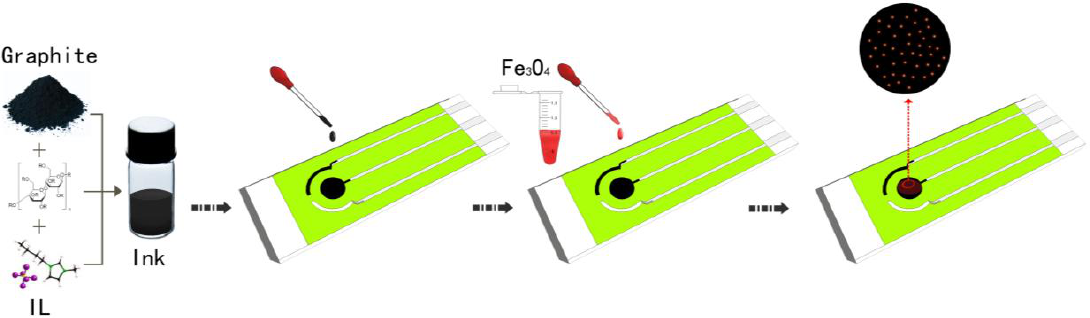
Figure 1. Fabrication and modification process.